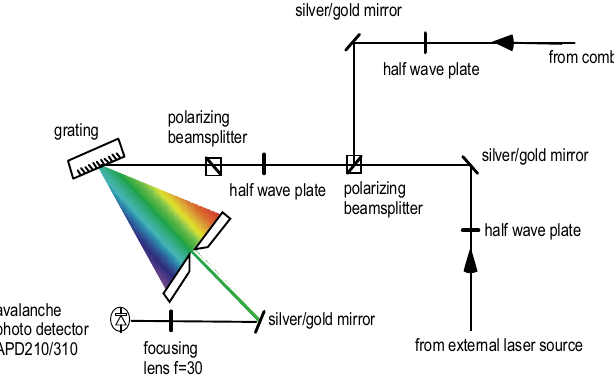
Fig. 3. Beat detection